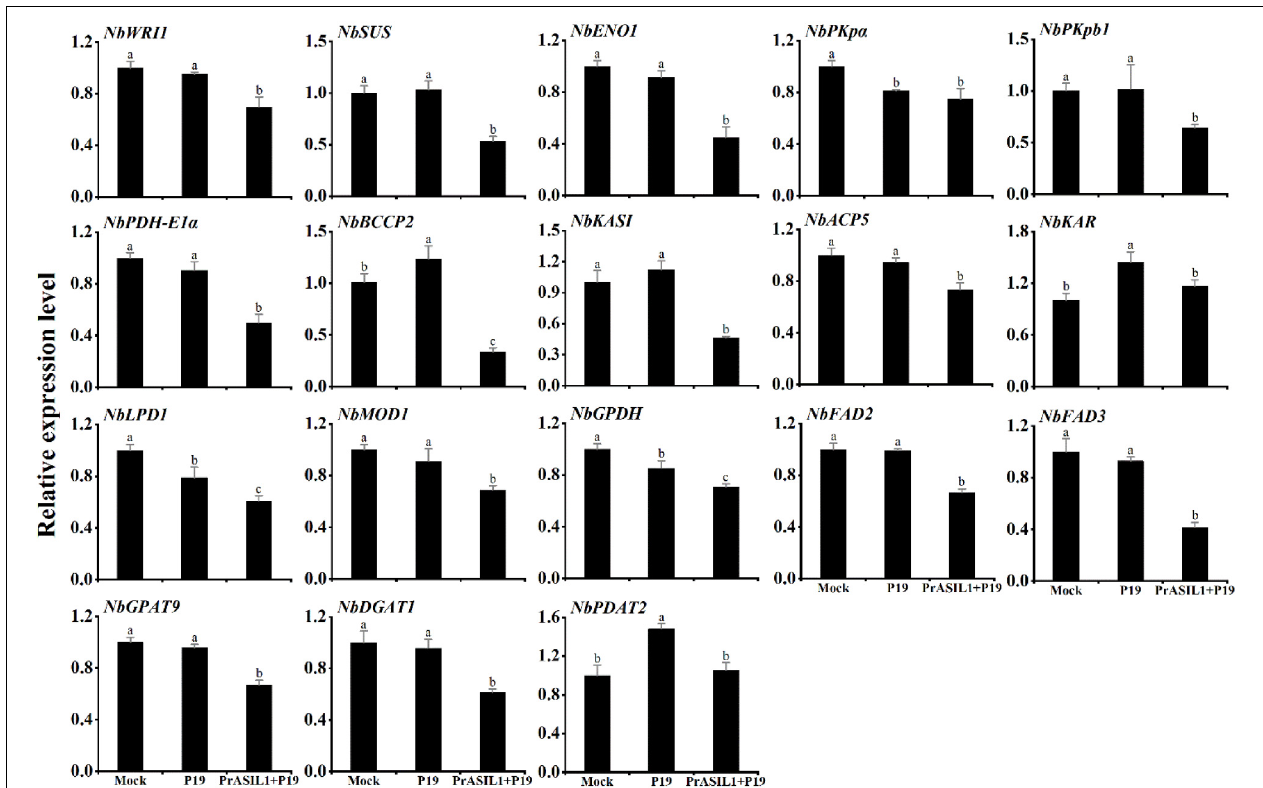
FIGURE 4 | Comparison of the expression levels of genes involved in FA biosynthesis to TAG accumulation among PrASIL1- transformed, mock, and P19-transformed N. benthamiana leaf tissue. Results were normalized to the expression of NbL23 and calibrated to the levels of mock tobacco leaves. Values are means ± SD ( n = 3). Different letters indicate significant difference at P < 0.05, as confirmed by one-way ANOVA with Tukey’s